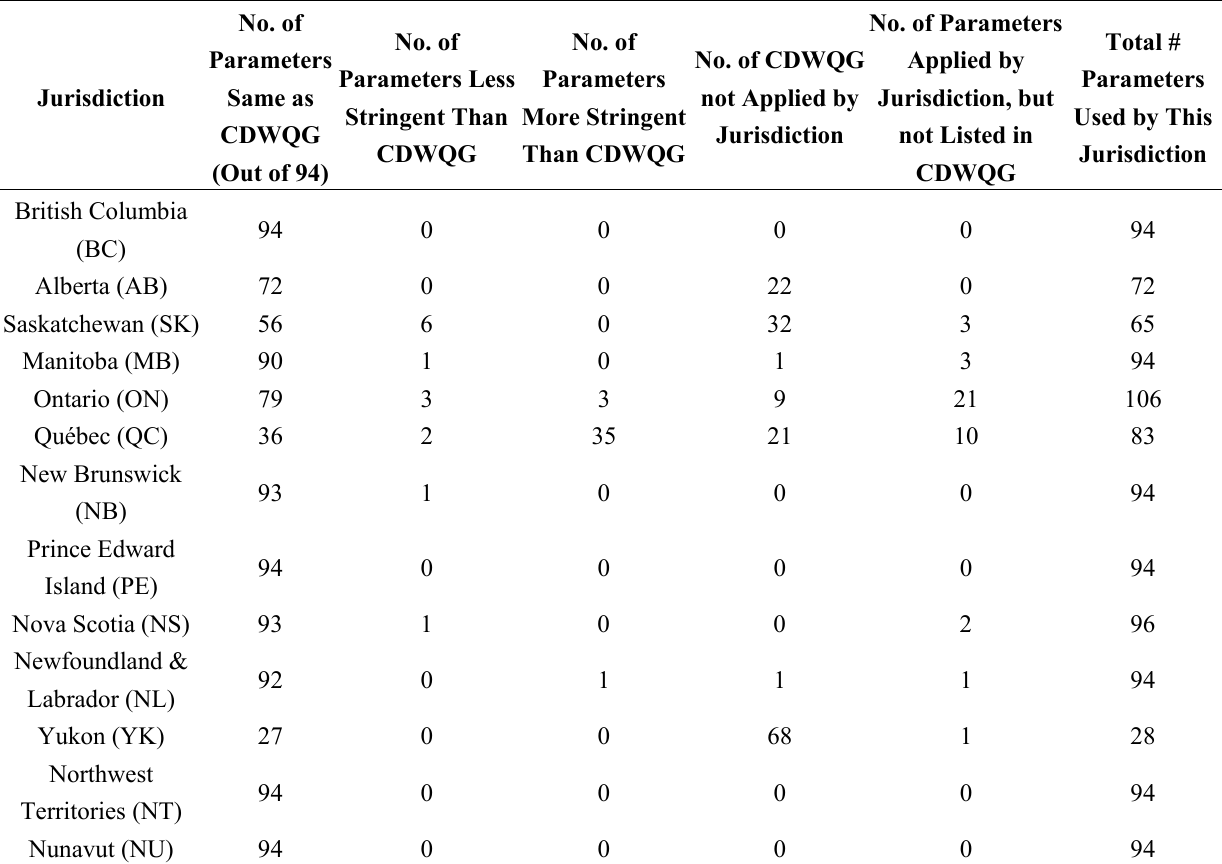
Table 2. Use of CDWQG parameters in Canadian provinces and